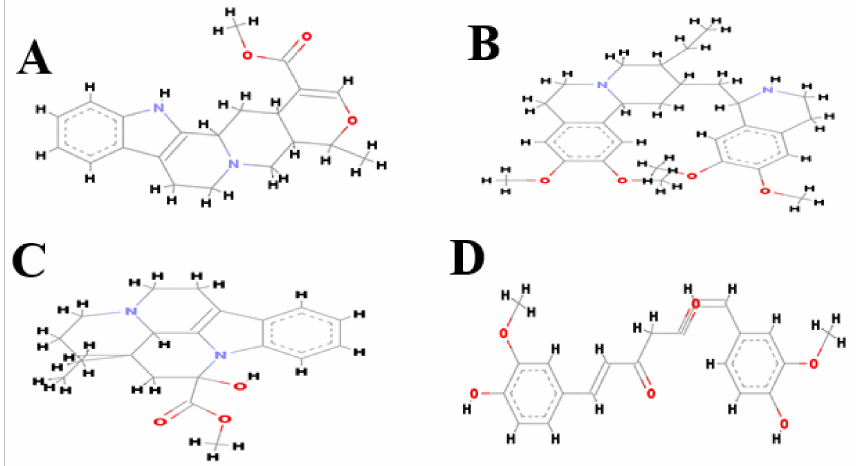
Figure 5. 2D chemical structure of the compounds: ( A ) ajmalicine, ( B ) emetine, ( C ) vincamine, ( D )